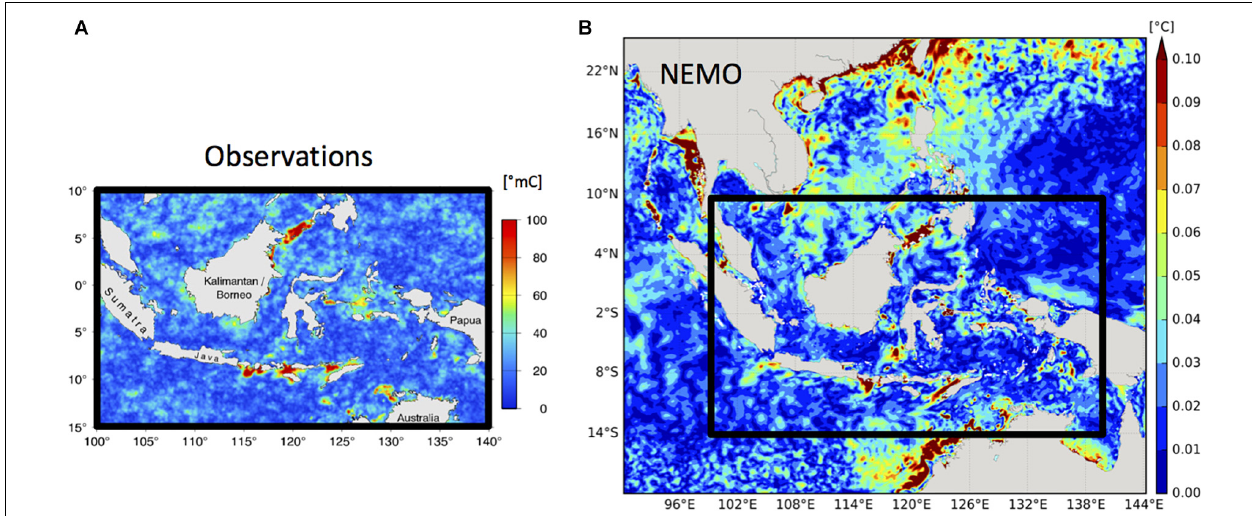
FIGURE 9 | Amplitude of the spring-neap (MSf) tidal component in sea surface temperature, extracted from (A) over 12 years of MUR-SST data (in ◦ mC) (Figure from Ray and Susanto, 2016) and from (B) the NEMO INDESO model (in ◦ C). High amplitude (red) indicates strong tidal mixing. (Figure from Nugroho et al., 2017. Permission obtained from